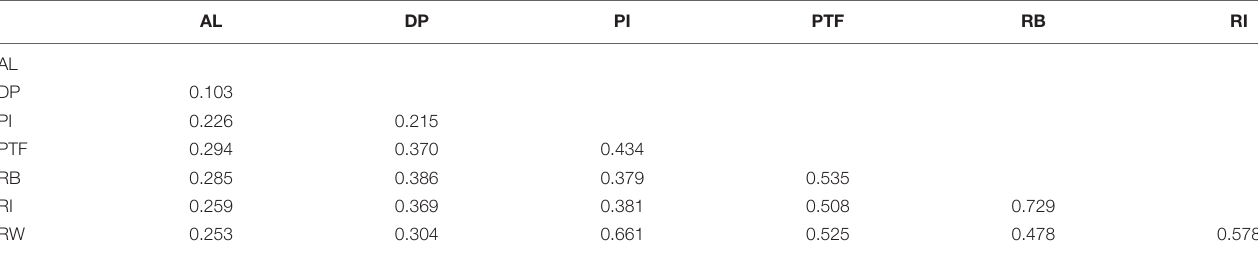
TABLE 4 | Heterotrait–monotrait